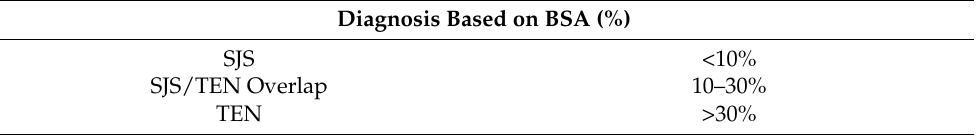
Table 1. Diagnosis of Stevens-Johnson Syndrome (SJS) and Toxic Epidermal Necrolysis (TEN) based on body surface area (BSA) (%)